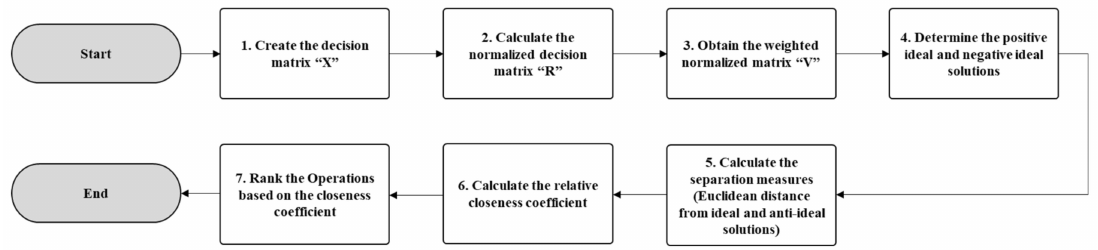
Figure 5. TOPSIS